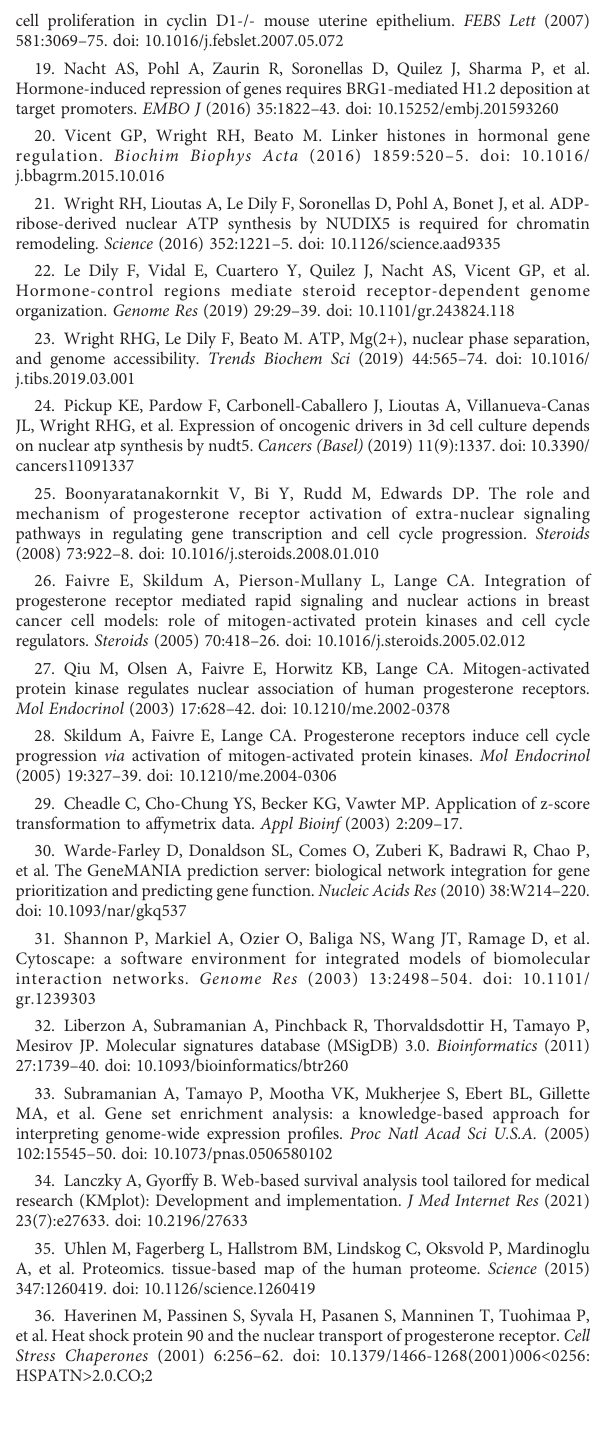
dataset encompassing 321 proteins in Cytoscape using Genemania ™ only considering protein-protein interactions with experimental evidence each